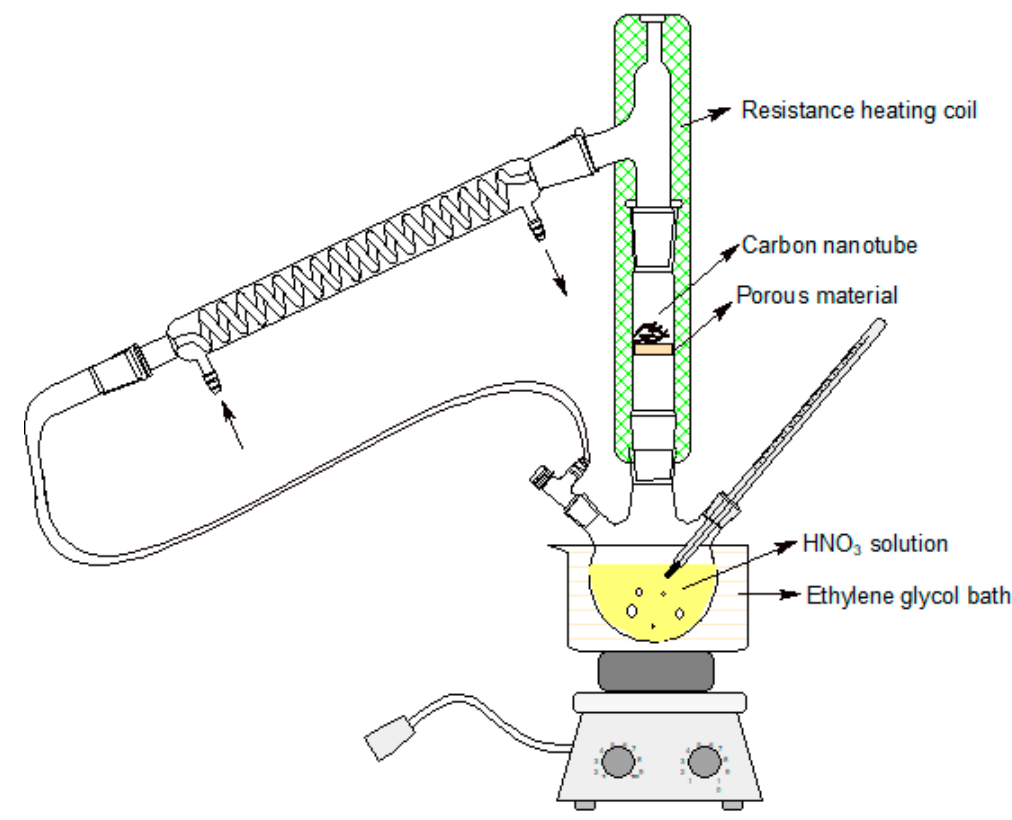
Figure 1. Schematic illustration of the set-up used for vapor phase functionalization of carbon nanotubes (CNTs) with HNO 3.